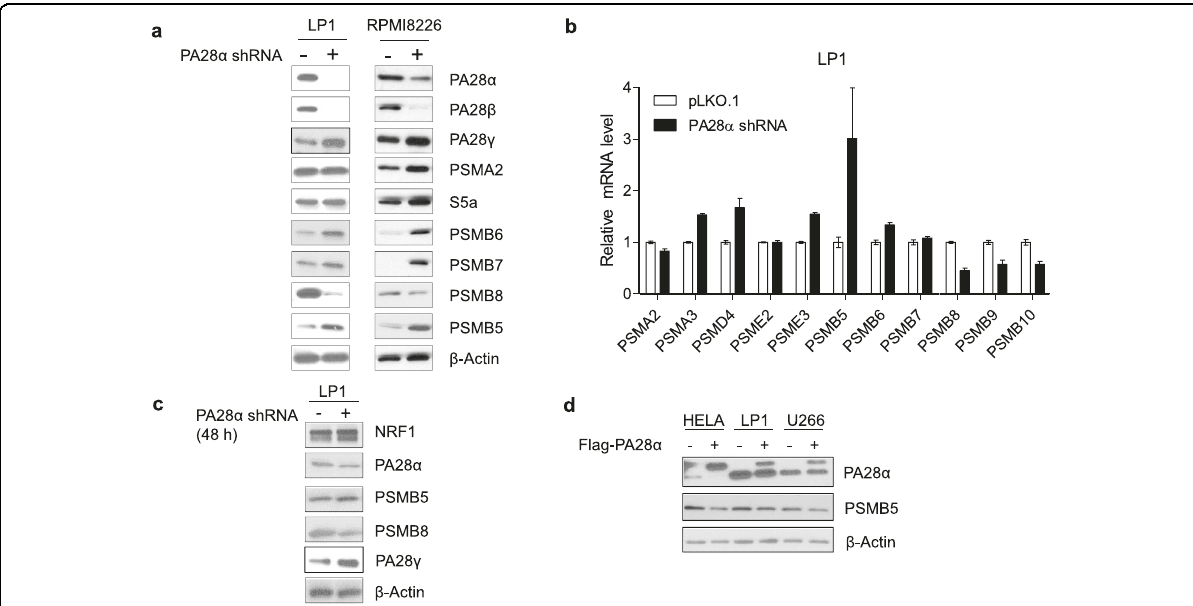
Fig. 4 PA28 α regulates proteasome subunits expression. a Western blot of proteasome subunit expression from LP1 and RPMI8226 PA28 α knockdown and control stable cells, β -actin as a loading control. b Real-time qPCR assay of proteasome subunits transcript levels from LP1 PA28 α knockdown and control stable cells, β -actin as an endogenous control. c LP1 cells were transiently transfected with shRNA targeting PA28 α or control vector, 48 h after transfection proteasome components expression were checked using western blot. d HeLa, LP1, and U266 cells were transiently transfected with Flag-PA28 α vector or Flag empty vector, 48 h after transfection, cell lysates were collected, and western blot was performed to check PA28 α and PSMB5 expression, β -actin as a loading control.